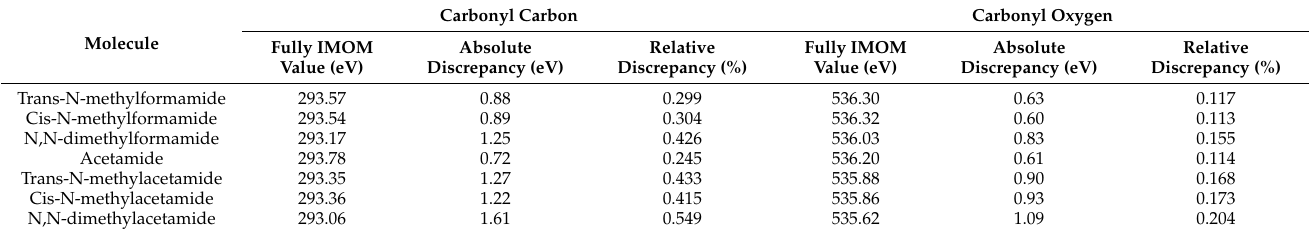
Table 3. Absolute and relative discrepancies of the IMOM/ELMO 1s core-ionization energies for the carbonyl carbon and carbonyl oxygen atoms involved in the peptide bonds of the analyzed biomimetic molecules, always with respect to the corresponding fully IMOM reference values (also reported in the table). The results were obtained at PBE0/6-311++G(d,p) level. Carbonyl Molecule